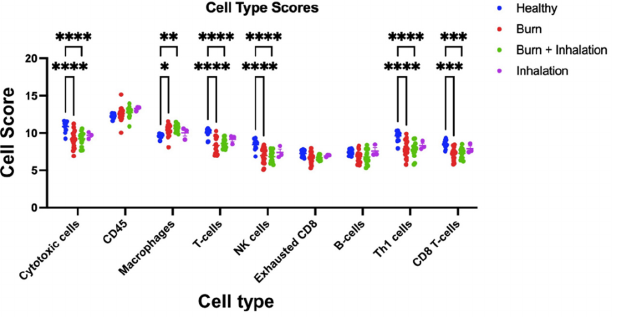
Figure 4. Burn injury alone and combined BI injury, but not inhalation injury alone, induce significant alterations in the composition of the peripheral immune cell populations compared to healthy controls. mRNA was isolated from PBMC which was isolated from burn patients or healthy controls and expression of immune gene mRNAs canonically associated with specific immune cell populations were analyzed in order to calculate cell type scores allowing for characterization of the cellular components within the PBMC. One-way ANOVA with Bonferroni’s multiple comparisons was used to determine significance. Data shown ± SEM; * p < 0.05, ** p < 0.01, ***, p < 0.005, ****, p < 0.001.